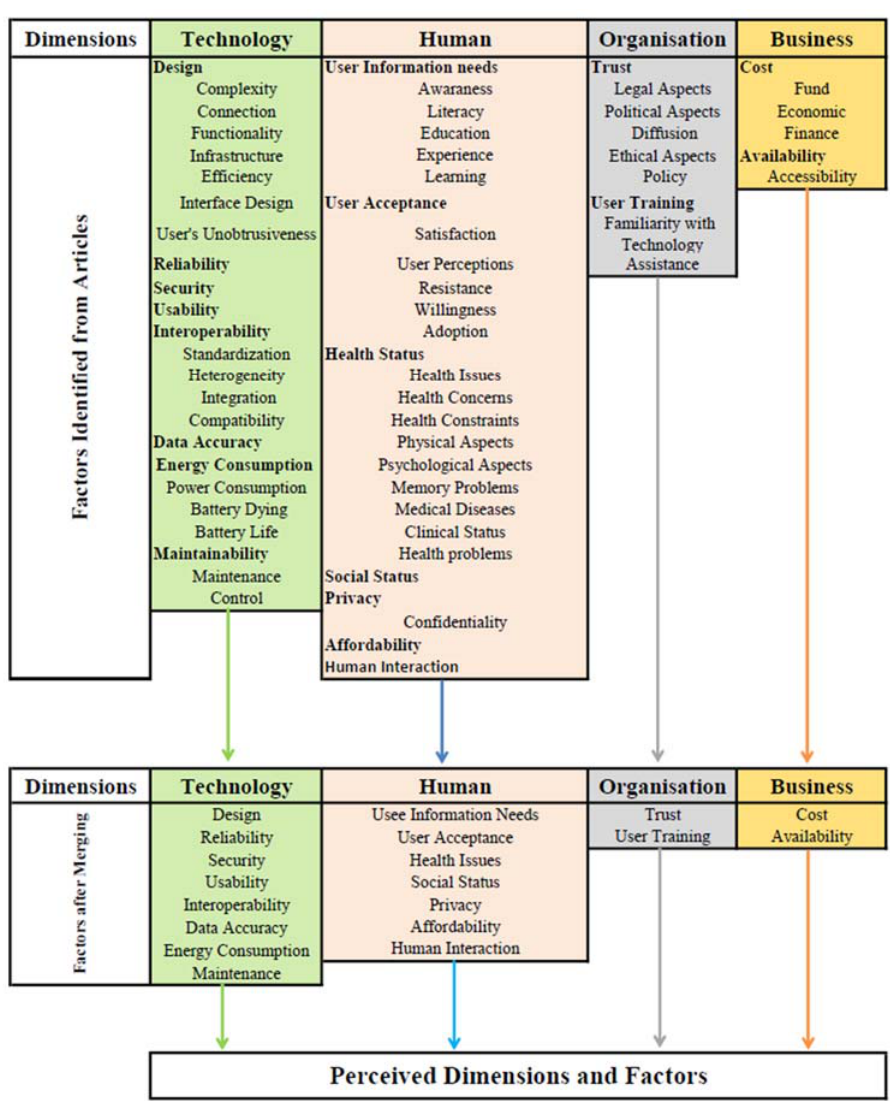
Figure 3. The dimensions and factors after revision.